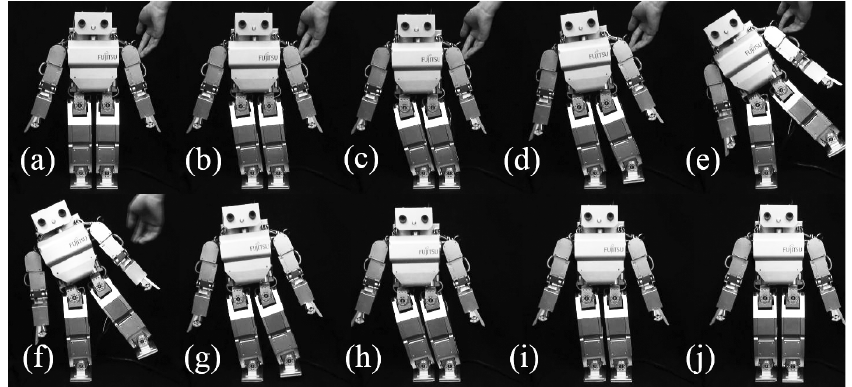
Figure 12. Snapshots from the experiment with a HOAP-2 robot responding to an unknown continuous-force disturbance on the shoulder (frontal plane). ( a–c, i and j ) ankle strategy; (d–g) lift-leg strategy; (h) transition between the two strategies. Two di ff erent models in the